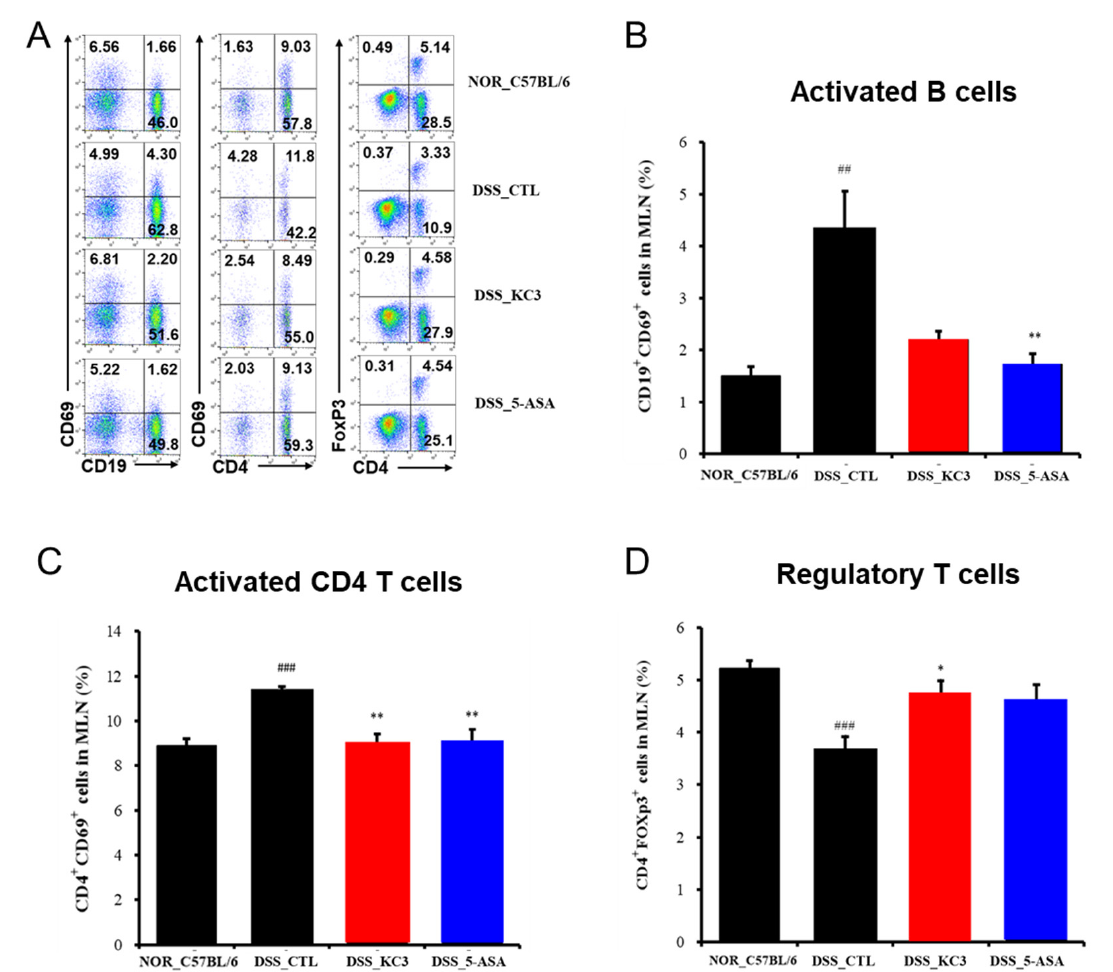
Figure 4. Immune cell phenotyping of mesenteric lymph nodes (MLNs) in mice of the DSS-induced colitis model. ( A ) Representative scatterplots of MLN flow cytometric immunophenotyping. Proportions of activated B cells ( B ), activated CD4 + T cells ( C ), and regulatory T cells ( D ) were measured using flow cytometry. The number on each box indicates the percentage of distinct population sorted by fluorescence signals. 5-ASA, 5-aminosalicylic acid. *, ** Significant difference compared with the DSS control group (negative control group, p < 0.05, p < 0.01). ## , ### Significant difference compared with the normal group ( p < 0.01, p < 0.001). Data are represented as mean ± SD ( n = 5 per group).